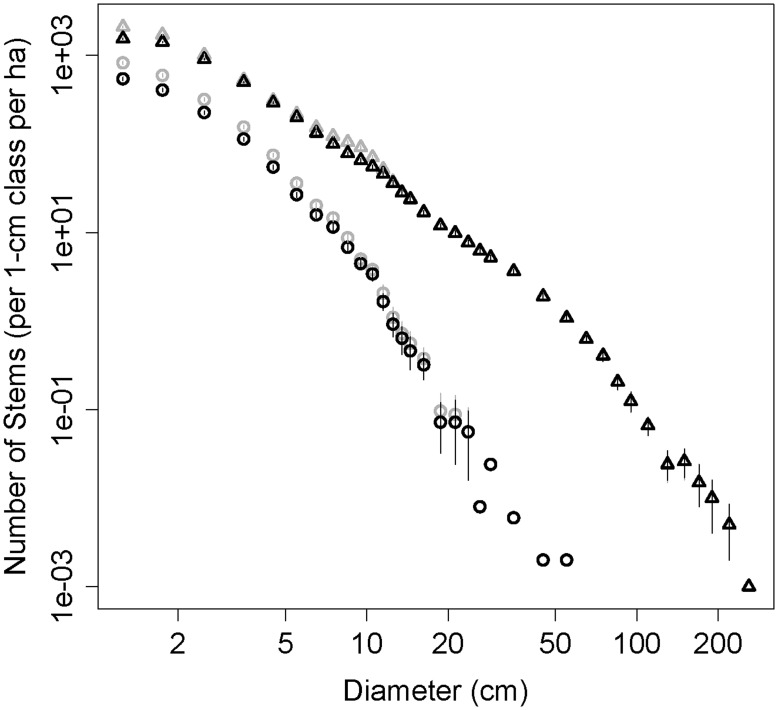
The number of liana and tree stems (log-transformed and excluding clonal stems) across 1 cm diameter size classes in the Barro Colorado Island, Panama 50-ha plot.Error bars represent 95% confidence intervals, which were calculated by bootstrapping over 20×20 m quadrants.